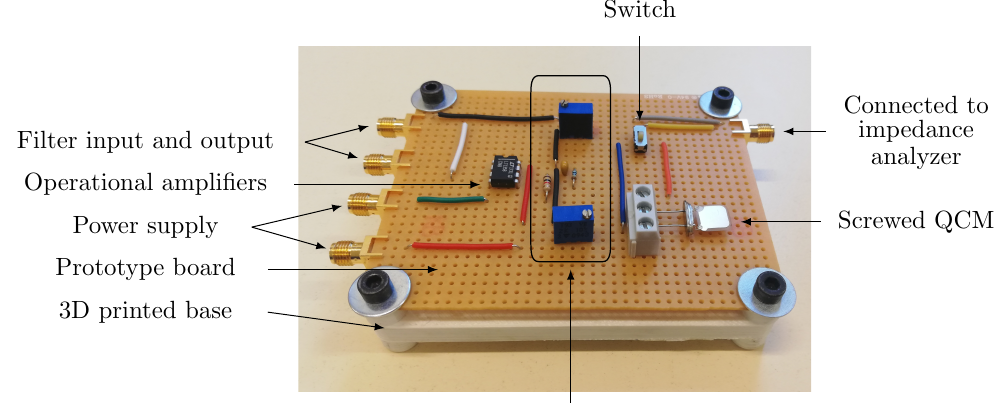
Figure 8. Picture of the fabricated QCM based resonator corresponding to Figure 7. The QCM is set horizontally in order to facilitate further mass deposition on its surface through a liquid drop